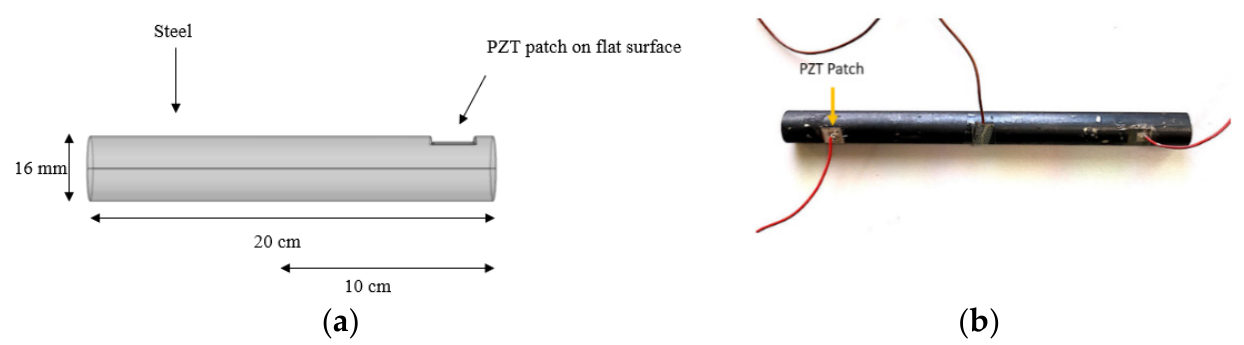
Figure 9. ( a ) Diagram of steel dimensions and ( b ) actual steel used in the experiments.